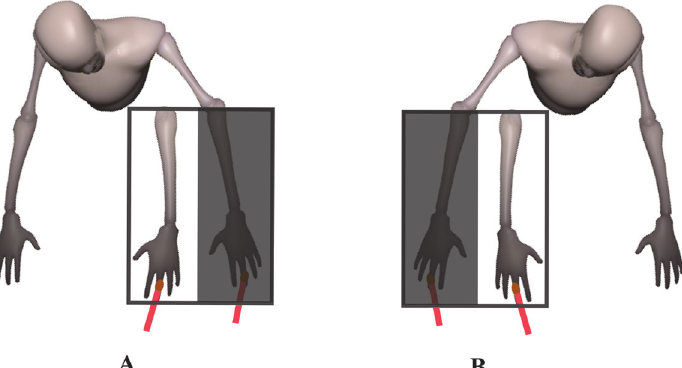
Fig 2. Picture of the experimental set-up. Left hand stimulation (Fig. 1A) and right hand stimulation (Fig.